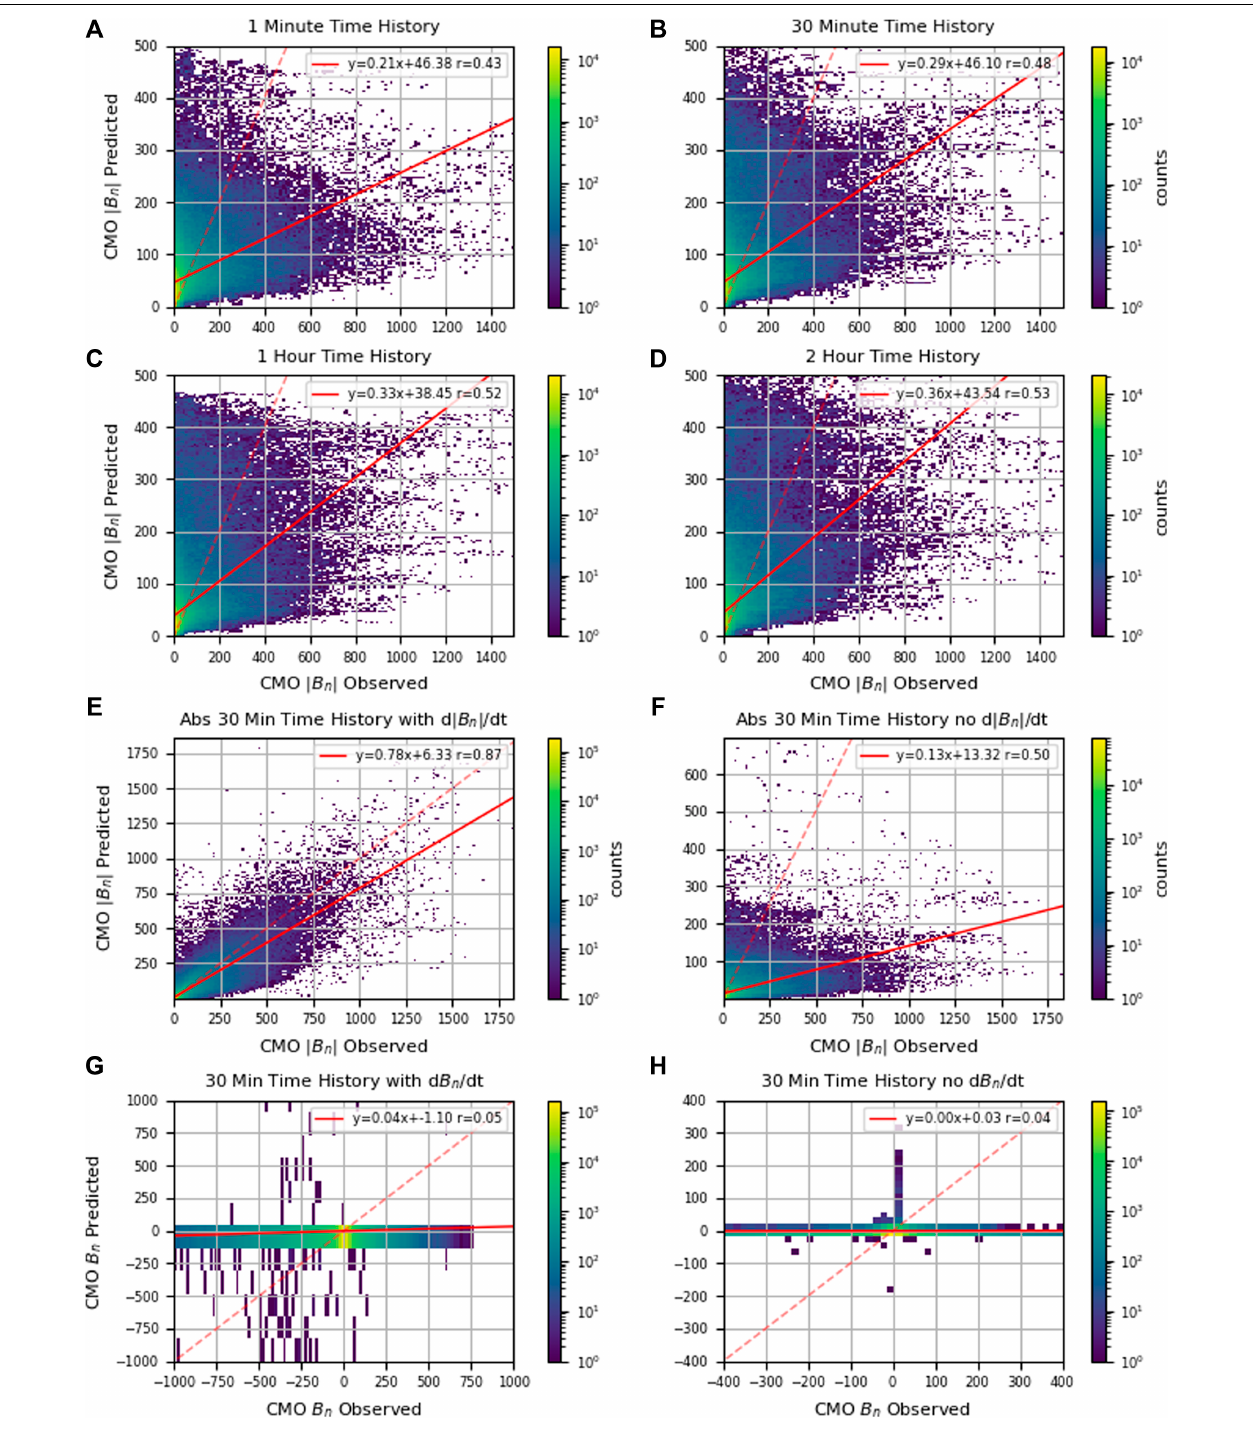
FIGURE 3 | Storm time density plots using 2015 as a test set showing the performance of the models shown in Figure 2 . The dashed red line indicates a perfect 1:1 correlation between predicted and observed values. The solid red line is a line of best fit correlation between the predicted values and the observed values. Subplots (A–D) show density plots of predicted vs observed values for 2015 CMO when utilizing 1−, 30−, 60−, and 120-minutes of time history. Subplots (E–H ) utilize the selected 30-minute time history model and compare predicting | B N | with and without d| B N |/dt information and predicting B N with and without d B N /dt information. We can see in subplots (G) and (H) that LSTM predicting B N provided significantly poor predictions with a correlation of 0 regardless of utilizing previous d B N /dt information as an input to the model. However, when predicting | B N | as seen in subplots (E) and (F) LSTM performs well, with a significant 74% increase in Pearson correlation when including previous d| B N |/dt information as an input parameter to the